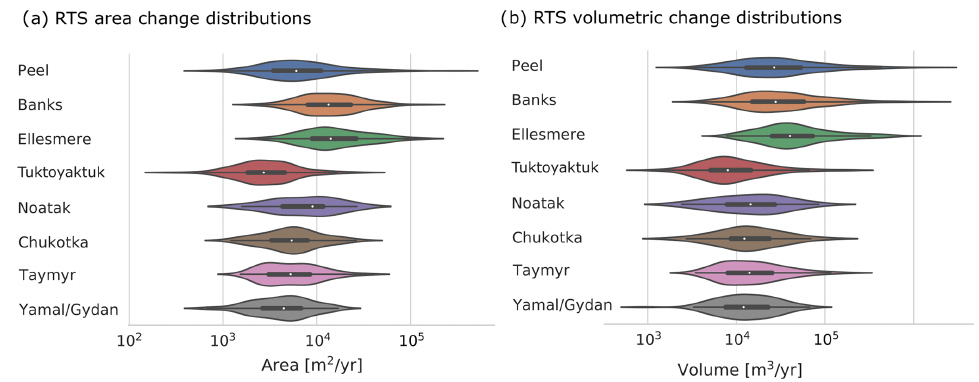
Figure 3. Area (a) and volumetric (b) change rate distributions of mapped RTSs in the form of violin plots. For each violin plot the white dot on the centre line indicates the mean value, the thick centre line shows the interquartile range, the thin centre line shows the total range of data, and the coloured area indicates the probability density of the data across the distribution of values smoothed by a kernel density estimator. Table 2. Number of RTSs in each study site with the total number of RTS and the volumetric change rates in terms of total change, density, and average rates per